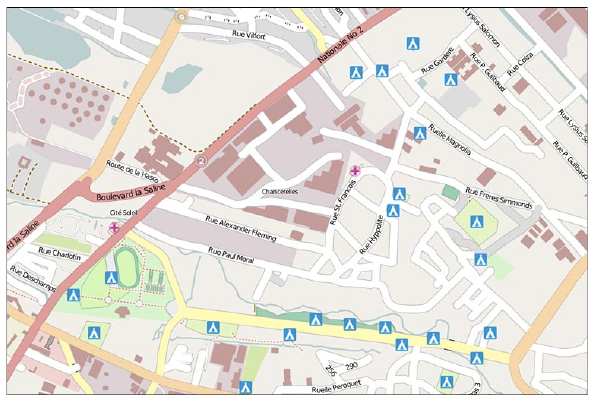
Figure 4. OSM Map of Port-au-Prince one week